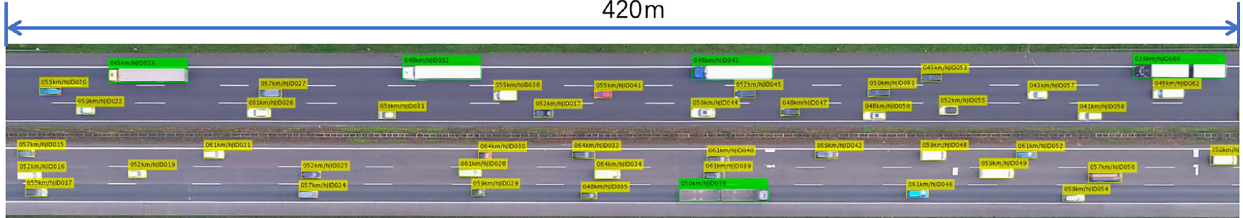
Figure 2 HighD data